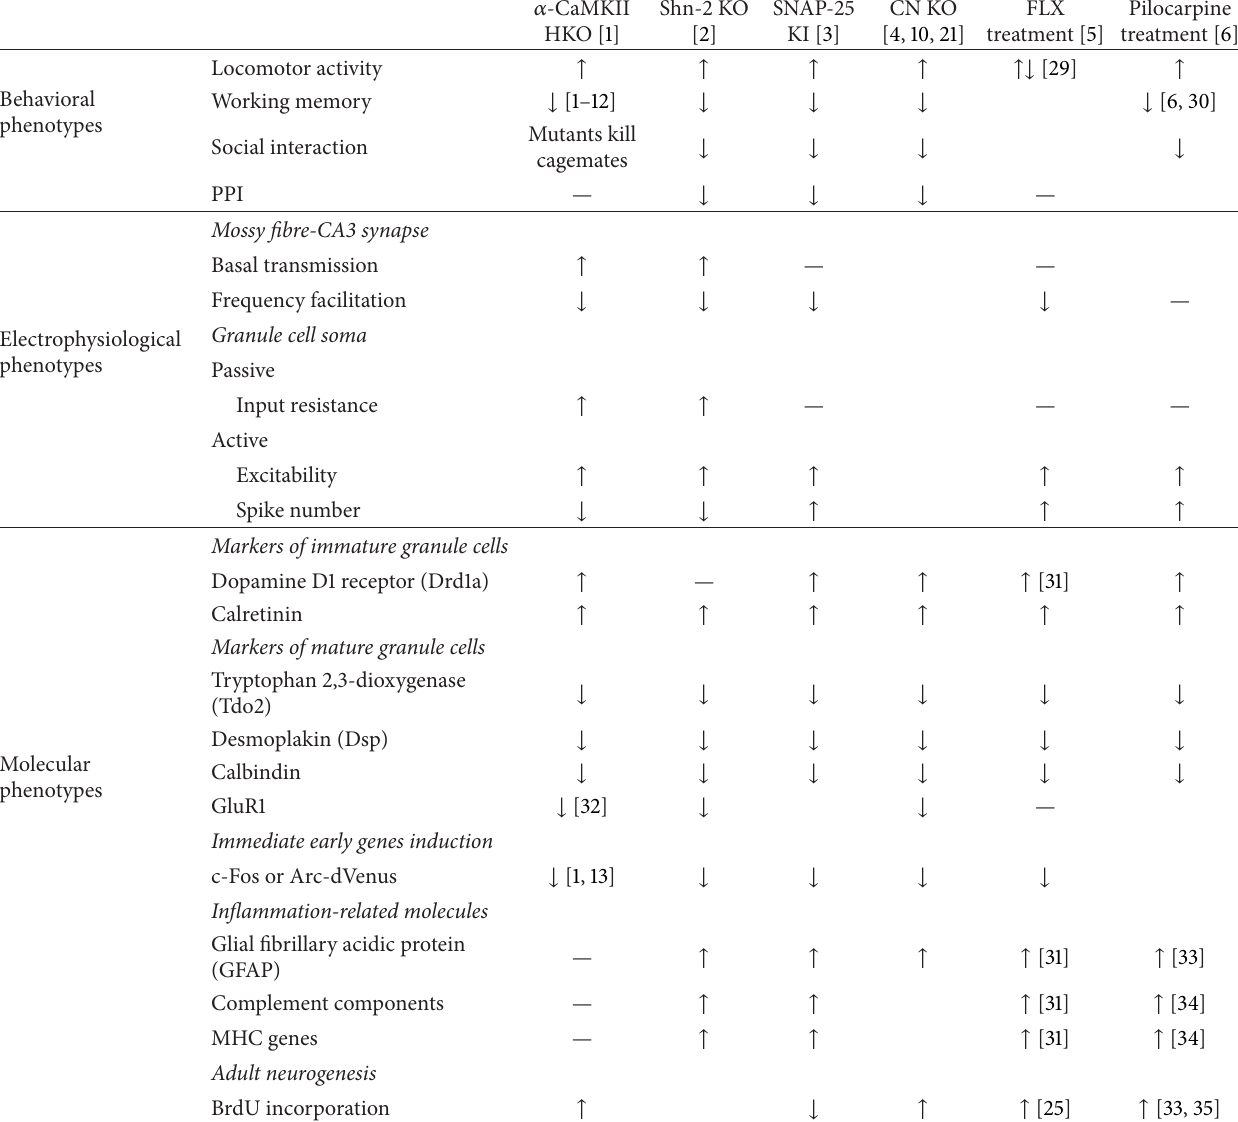
Table 1: Behavioral, electrophysiological, and molecular phenotypes in mice with